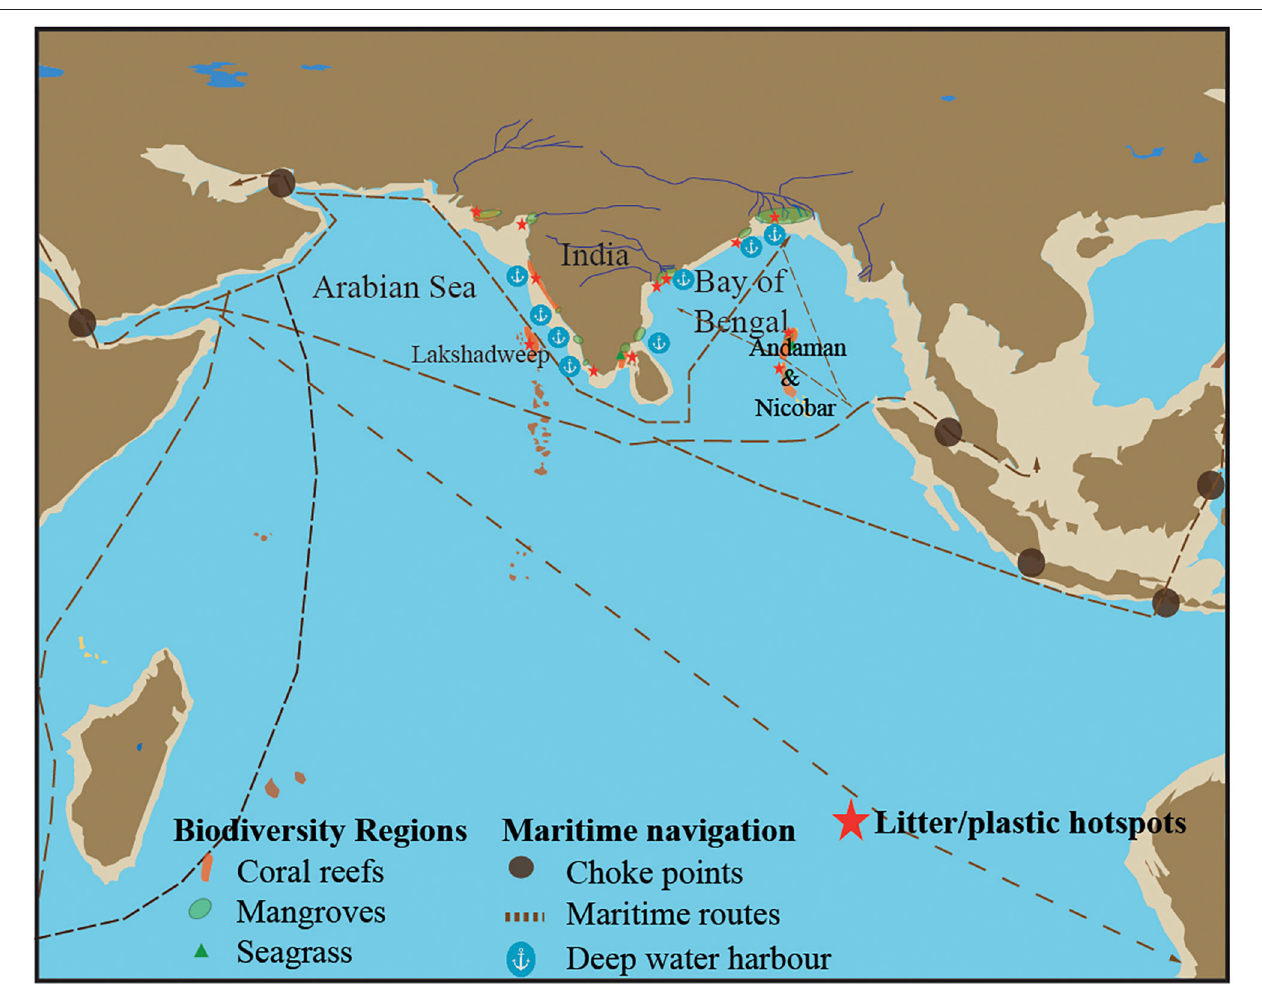
FIGURE 1 | Map of India showing important biodiversity regions, maritime routes, and potential plastic accumulation